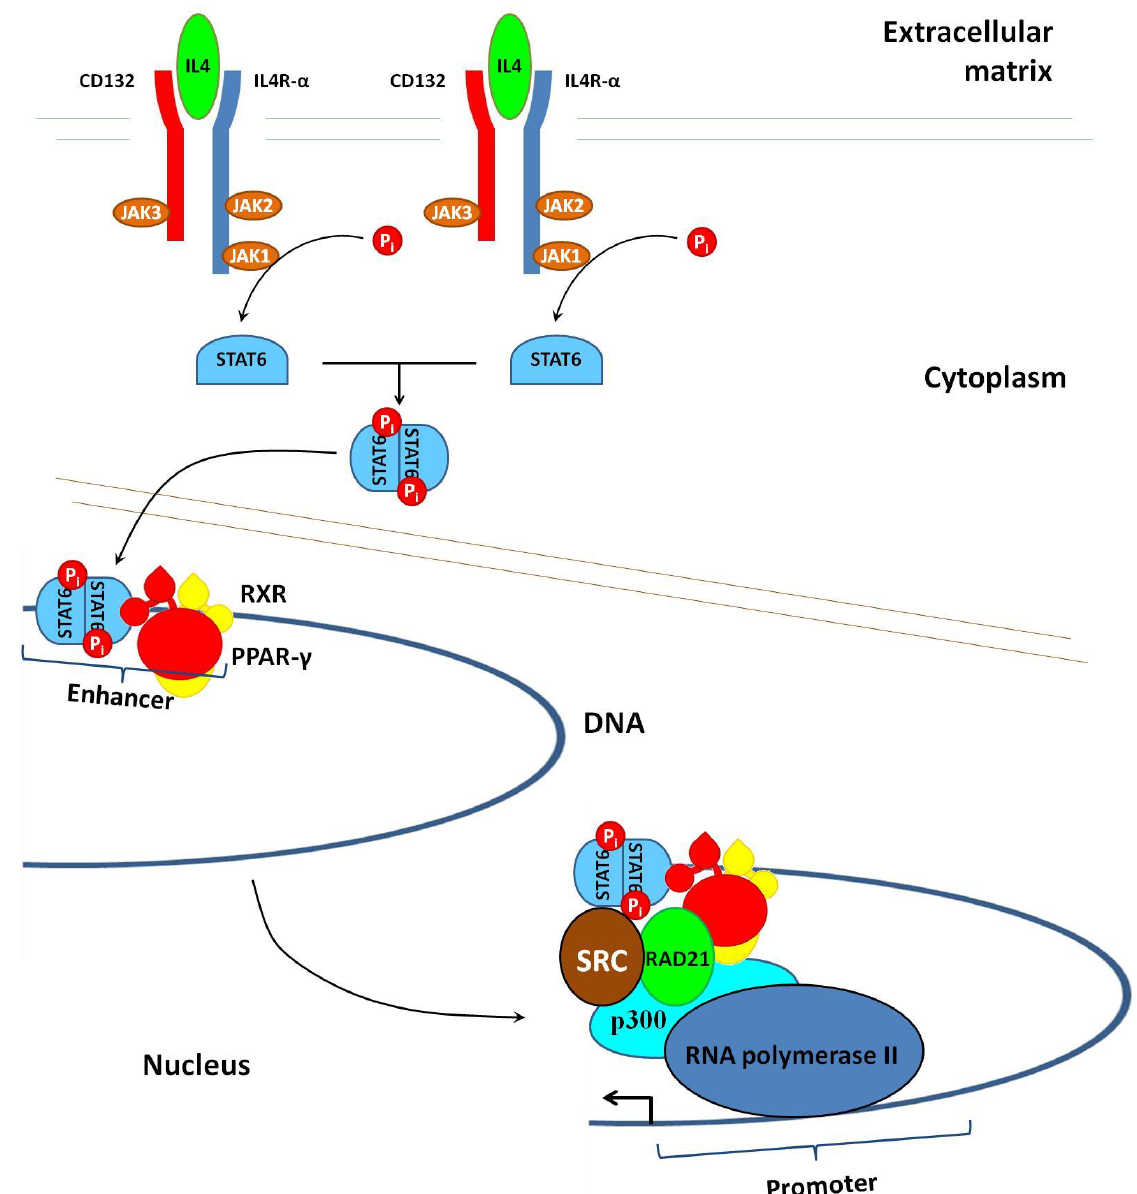
Figure 4. Transcriptional activation of the genes involved in polarization of macrophages toward the anti-inflammatory M2 phenotype. Binding of IL4 to the specific receptor (IL4R- α) triggers phosphorylation of the transcription factor STAT6 by JAK1. Phosphorylated STAT6 homodimer- izes and then crosses to the nucleus, where it interacts with IL4-sensitive/RGS-insensitive enhanc- ers of the DNA. This interaction recruits the heterodimer of agonist-free PPAR- γ and RXR, which are transcriptional activators. It also causes structural changes in the chromatin, making it accessi- ble for RNA polymerase II and the transcription of